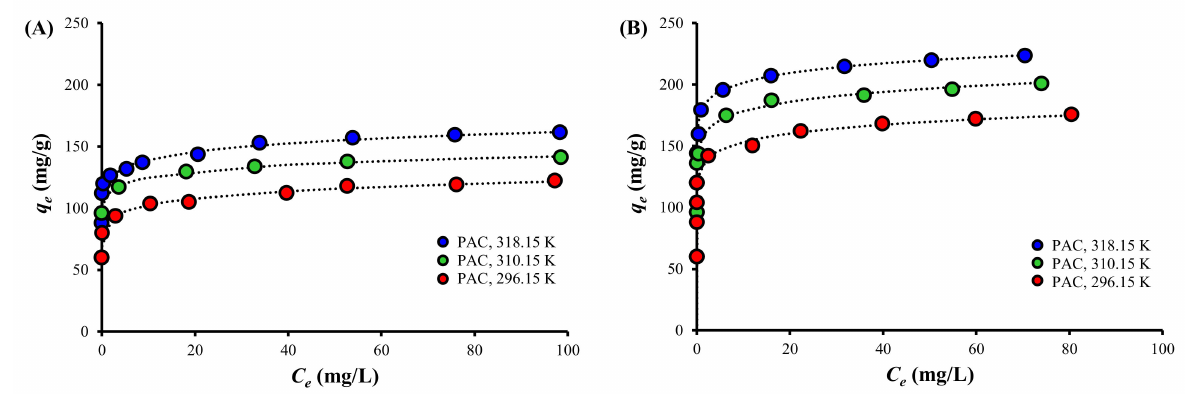
Figure 4. The experimental results of TC adsorption isotherm by ( A ) PAC and ( B ) PAC800 at different temperature and the fit of Freundlich isotherm model (dotted